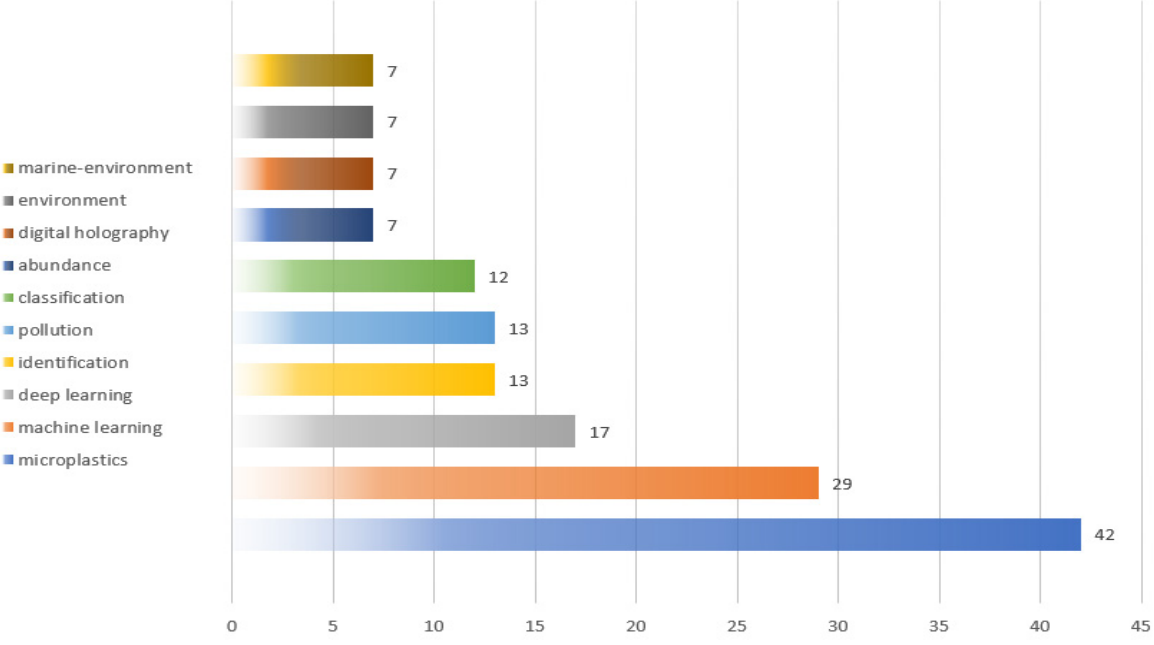
Figure 5. Top 10 high frequency keywords.